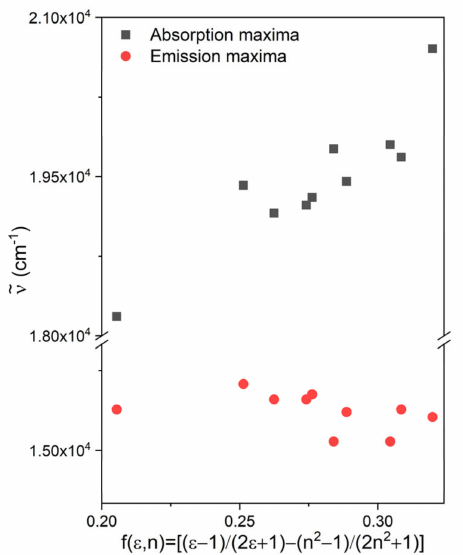
Figure 4. Plot of the wave numbers of the charge transfer (CT) transition of PhSt vs. solvent polarity